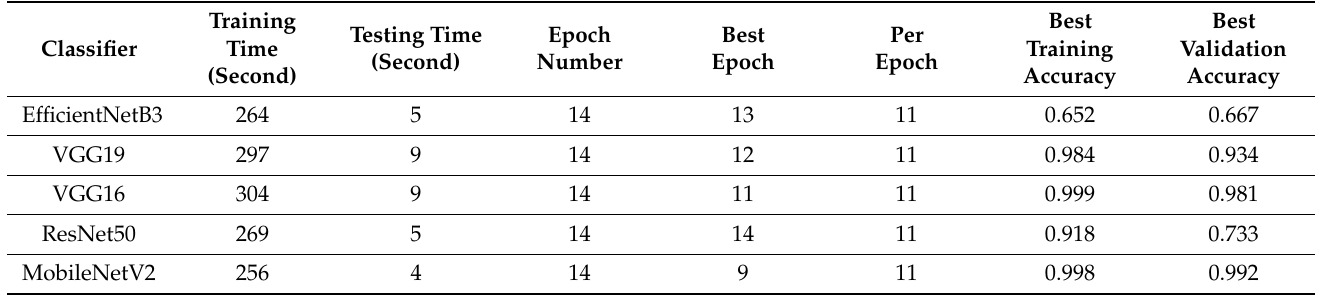
Table 5. Training and validation times with the best accuracy